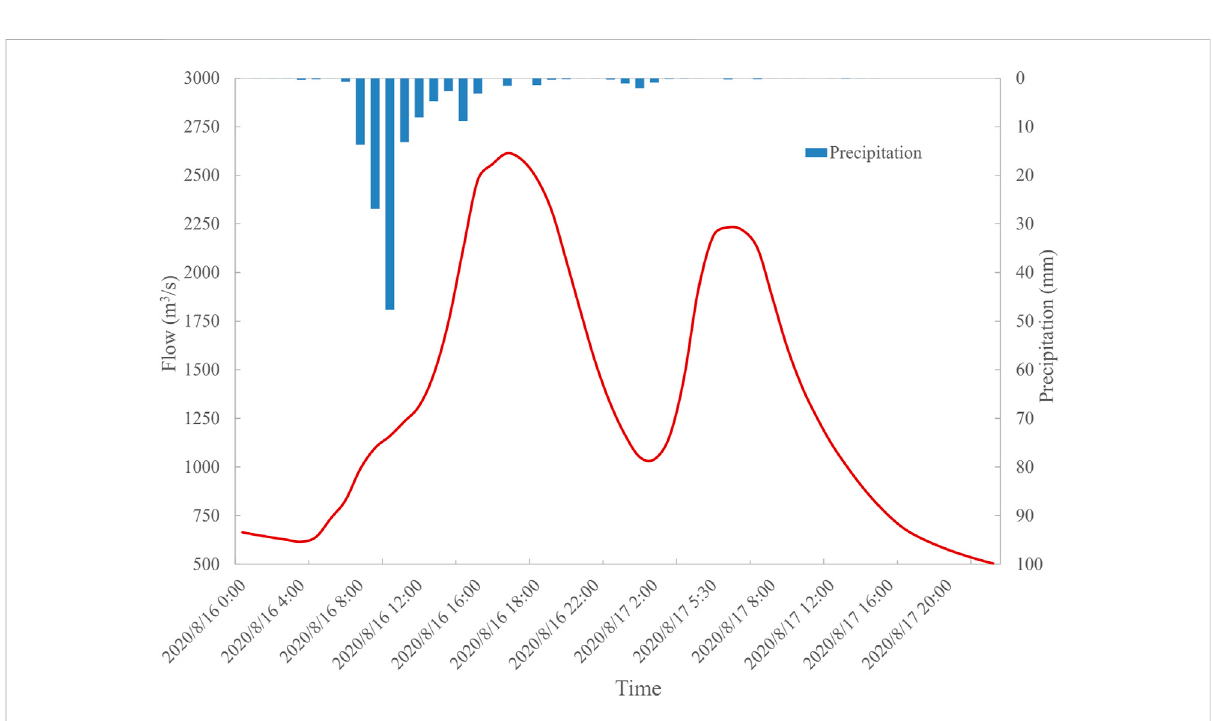
FIGURE 3 Flow hydrograph simulated by hydrological model on 16 August